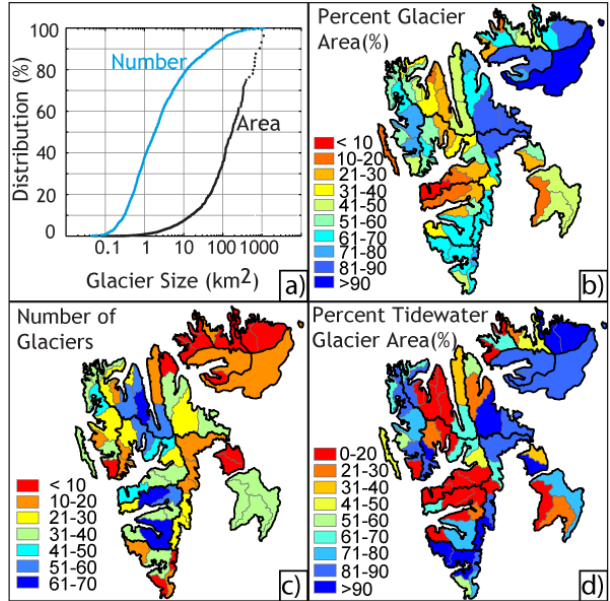
Fig. 4. (a) Glacier number and area distribution of the GI 00s inven- tory. E.g. 80% of the glaciers in the inventory are less than 10 km 2 , which makes up less than 10% of the total Svalbard glacierized area. (b) Percent glacierized area of the secondary drainage basins. (c) Number of glaciers within secondary drainage basins reflects an inverse relationship to the percent glacierized area. (d) Percent tidewater glacier area for each secondary drainage basin shows the dominance of tidewater glaciers in Nordaustlandet and the three ice field clusters in Spitsbergen (south, northwest and